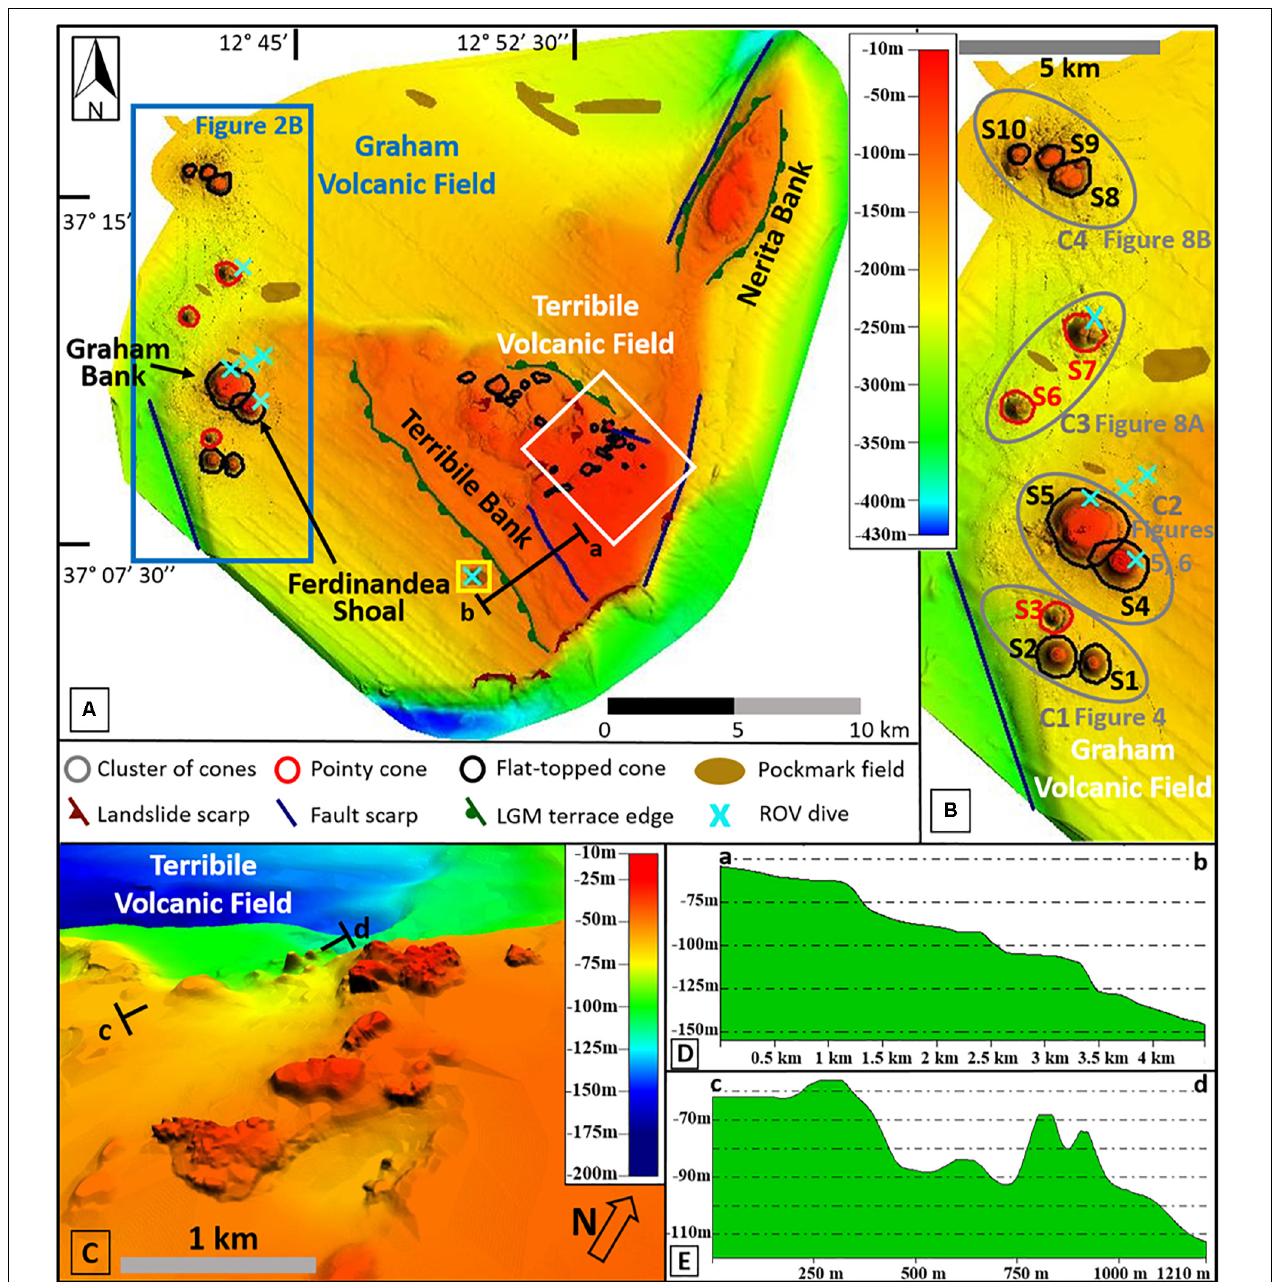
FIGURE 2 | (A) Bathymetry map of the study area displaying the Graham, Nerita and Terribile banks. The blue box shows the GVF, which is zoomed with higher resolution on (B) ; here the clusters of cones displayed in the next figures are indicated. The small yellow box images the area where the large pockmark of Figure 3 is located. The white box shows the eastern portion of the TVF, which 3D (vertical exaggeration is 4x) shaded relief image is displayed in (C) . (D) Bathymetric profile (ab) displaying the steps arrangement of the southwestern portion of Terribile Bank with four terraced areas, whose edges lie at about 130, 105–110, 85–90, and 60 m bsl. (E) Bathymetric profile (cd) displaying an alignment of small volcanic cones on top of Terribile